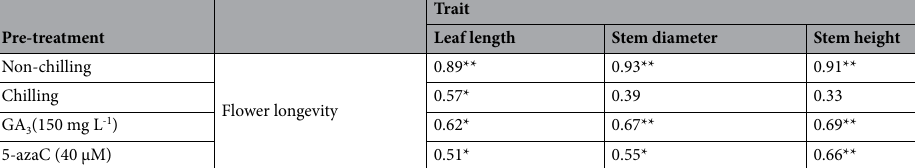
Table 8. Correlation coefficient between flower longevity and morphological indices of Anemone accessions under different pre-treatment conditions. *(Significant at 5% probability level) and ** (Significant at 1% probability